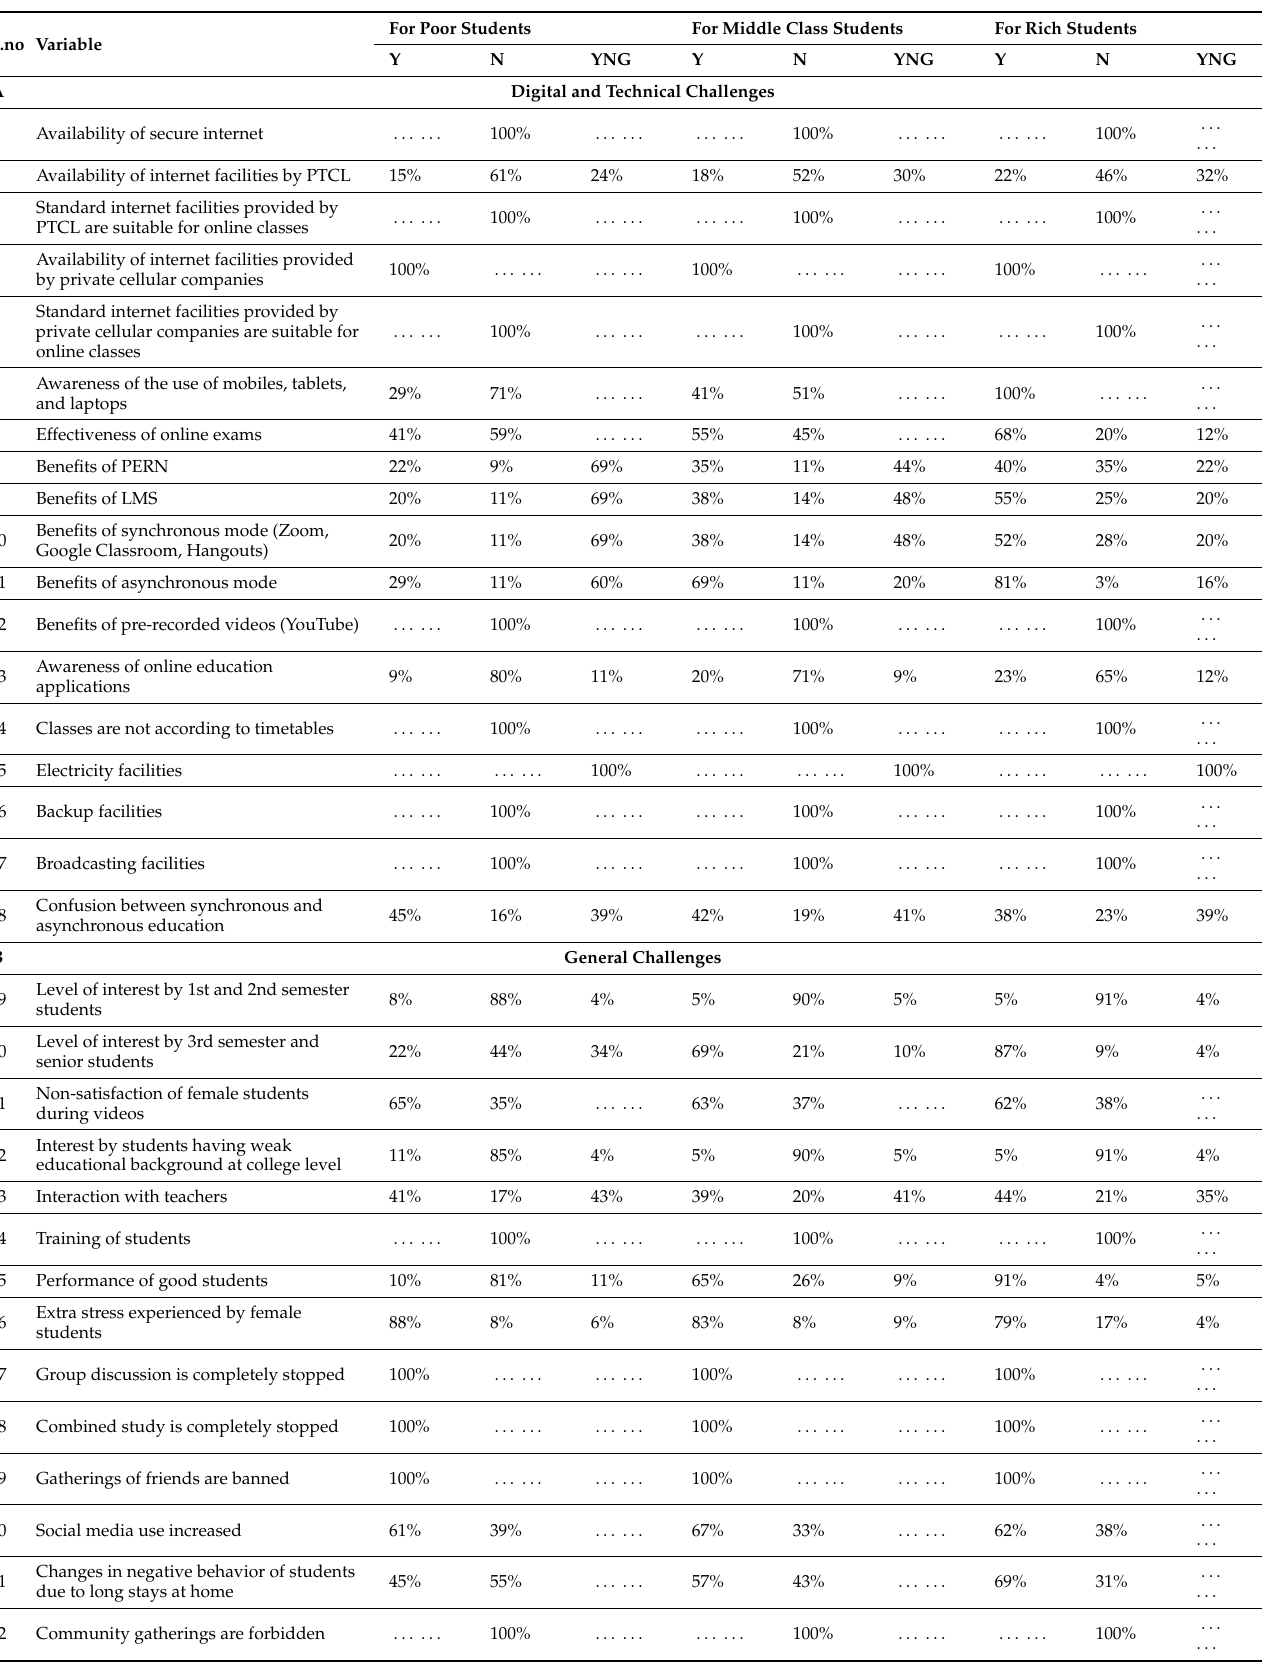
Table 2. Data collection of